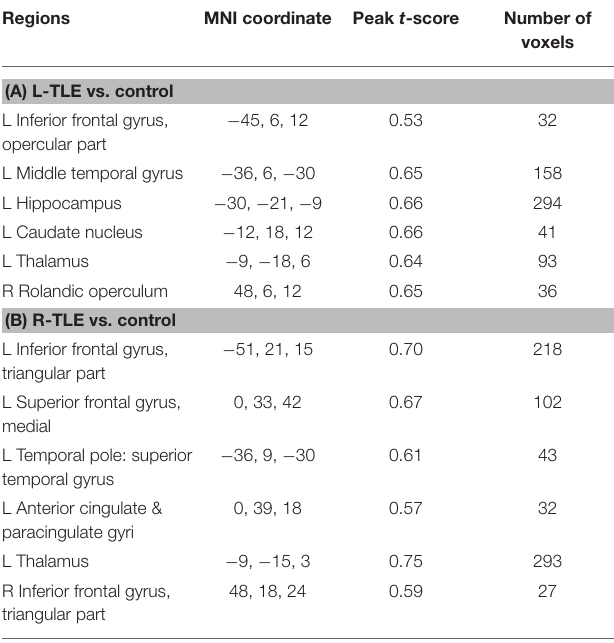
TABLE 6 | The associated cortical area, whose GMD changes had the same degree of volumetric changes of the thalamic unit on each side in L-TLE. Regions MNI coordinate Peak t -score Number of